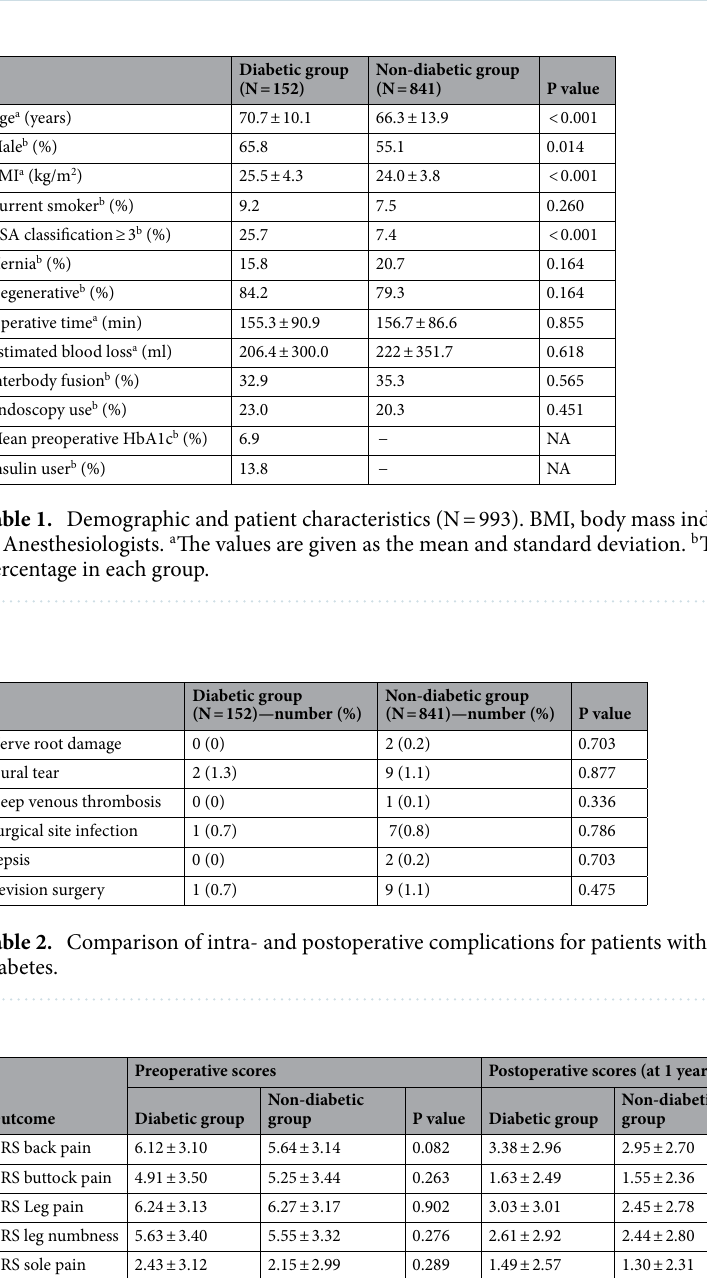
Table 3. Comparison of preoperative and postoperative scores for patients with diabetes and those without diabetes. NRS, Numerical Rating Scale; ODI, Oswestry Disability Index; EQ-5D, Euro quality of life-5 dimension. The P values were examined by Student’s t-test. The adjusted P values were calculated by the inverse probability weighted logistic regression model, setting the propensity scores based on patients’ age, sex, body mass index, smoking status, American Society of Anesthesiologists classification, operative time, and estimated blood loss.